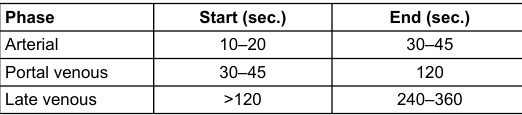
Table 1: Vascular phases in contrast-enhanced ultrasound (CEUS) of the liver: visualisation periods (in seconds) after the injection of the contrast agent Sonovue ®